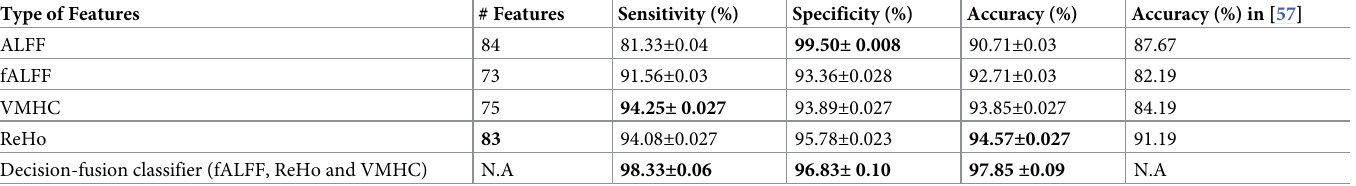
Table 3. Schizophrenia detection results with single-feature-type classifiers and decision-level classifiers. Feature selection was applied to each of the four single feature types (ALFF, fALFF, ReHo and VMHC). The decision-level classifier used all feature types except for the ALFF one, which has the worst performance. For comparison, the last column shows the corresponding accuracies obtained by Chyzhyk et al.